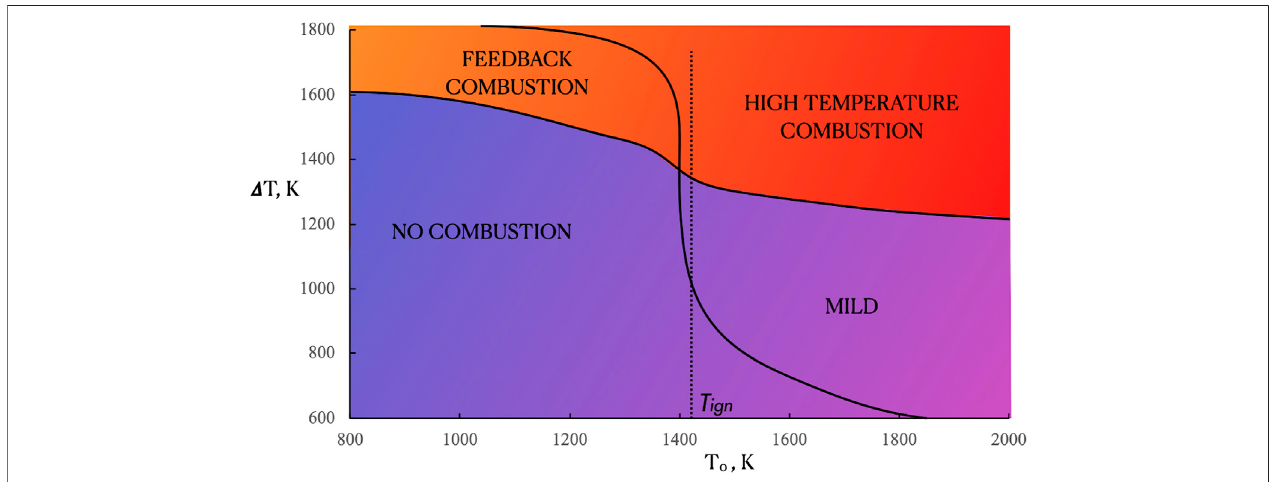
FIGURE 4 | Map of behavior for pure ammonia in the HFDF con fi guration at P (cid:1) 1 atm.